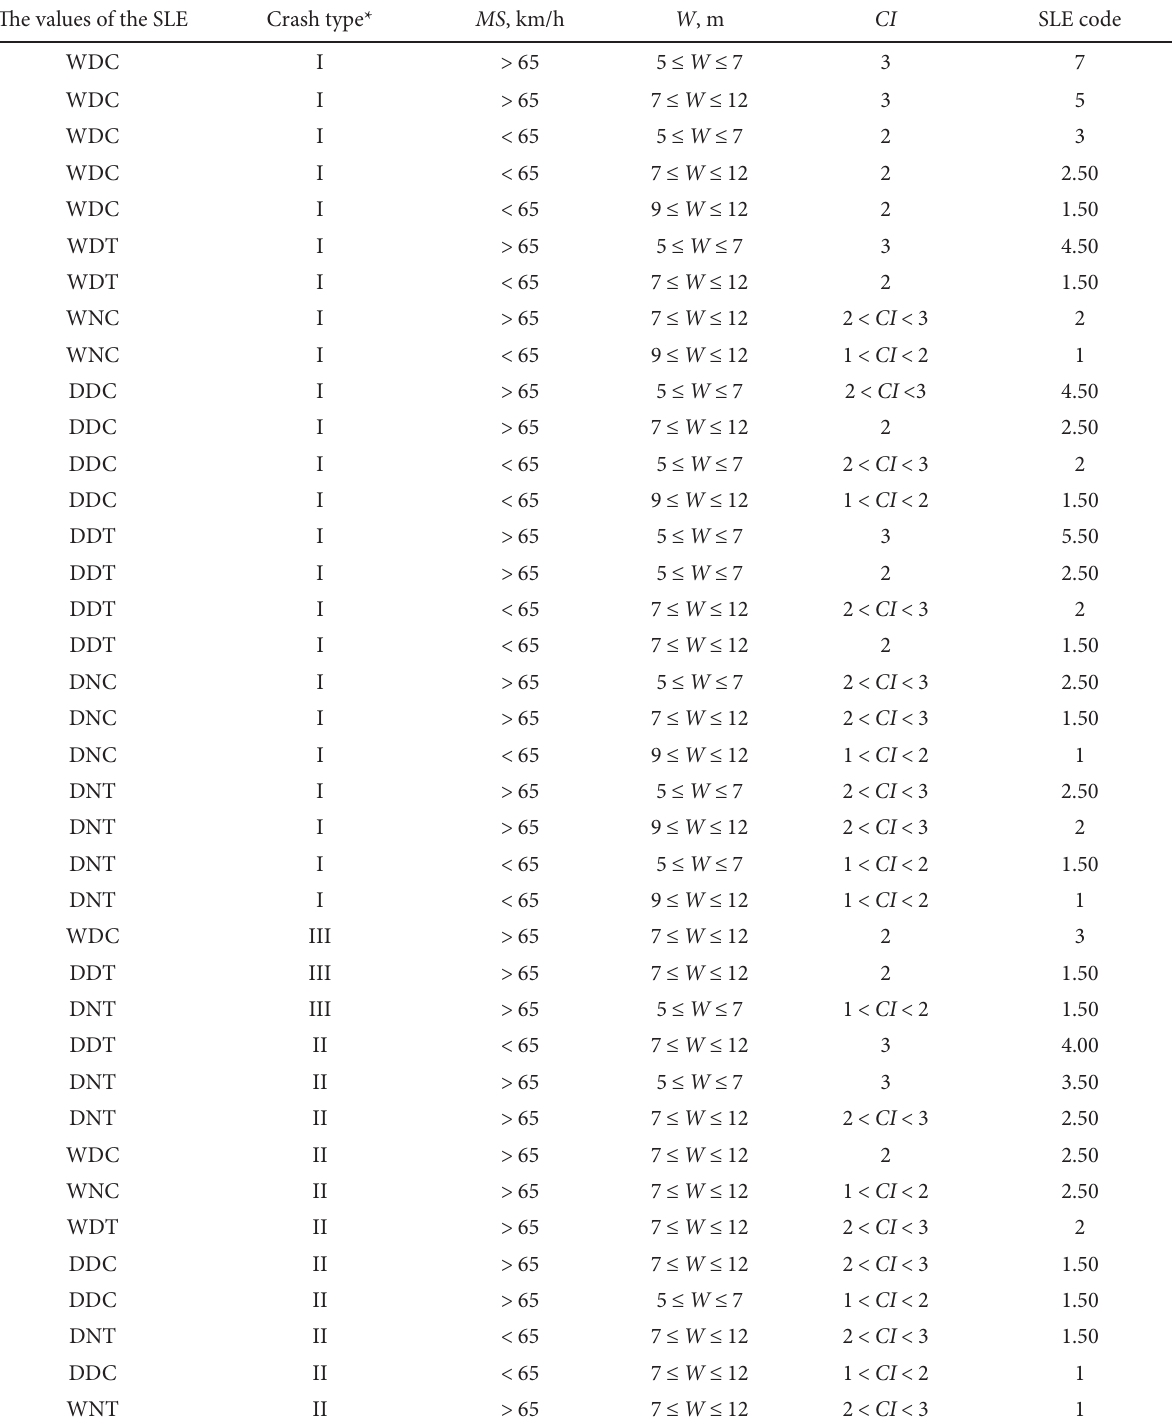
table 3. Assignment of the scenario variable code according to crash type The values of the SLE Crash